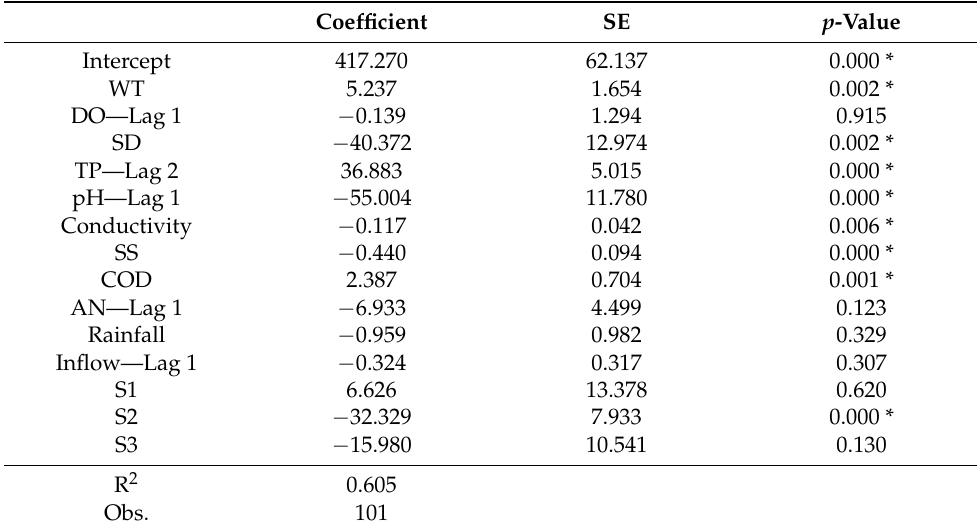
Table 7. Results from regression analyses of the Fongshan Reservoir